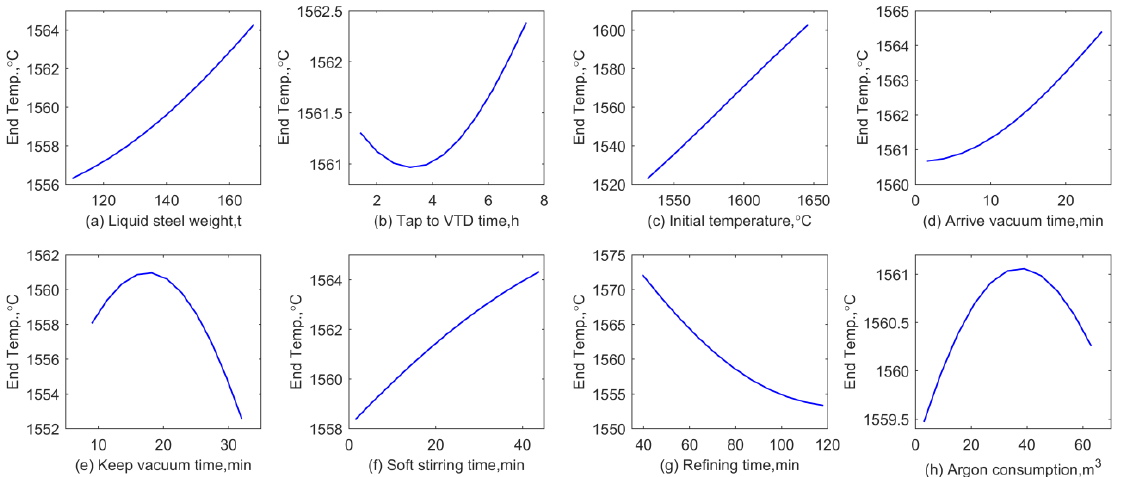
Figure 7. Sensitivity analysis of variables on the end temperature of liquid steel in VTD. The influencing factors are listed as ( a ) liquid steel weight, ( b ) tap to VTD time, ( c ) initial temperature, ( d ) arrive vacuum time, ( e ) keep vacuum time, ( f ) soft stirring time, ( g ) refining time, ( h ) argon